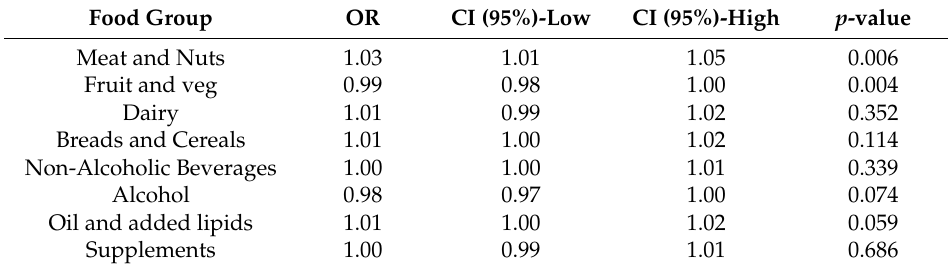
Table 4. Multiple logistic regression derived ORs and 95% CI with associated p -values per one standard deviation increment of the major categories of food groups for all ocular conditions